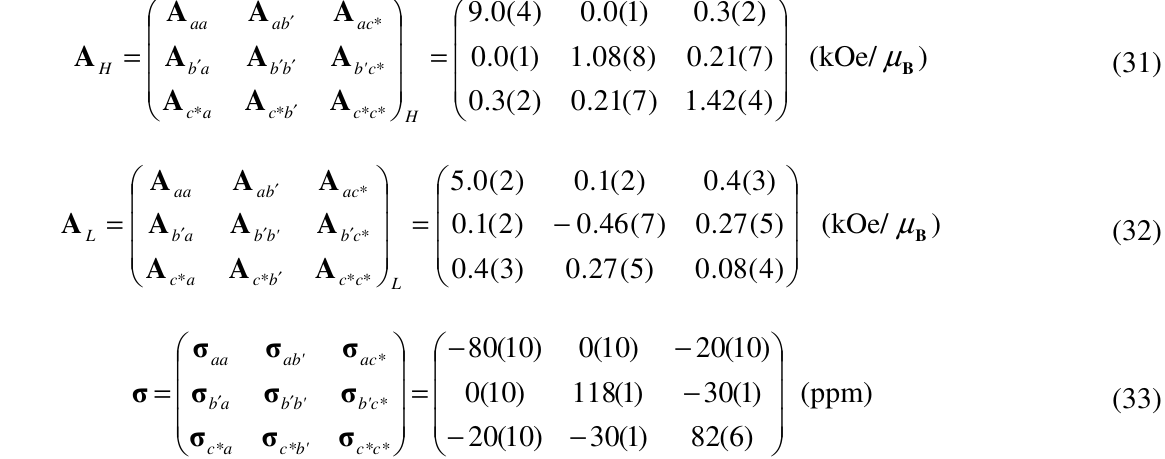
IBr ; ( b ) Angular dependence of NMR shift at A 2 2